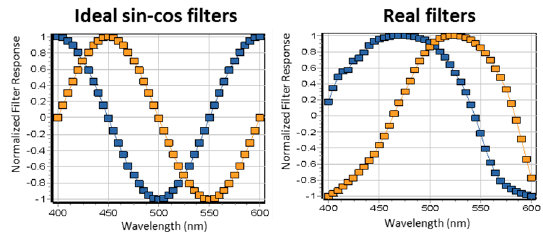
Figure 8. Ideal ( A ) and real ( B ) sin-cos filters response after normalization and shifting to give the range of the cosine and sine function.